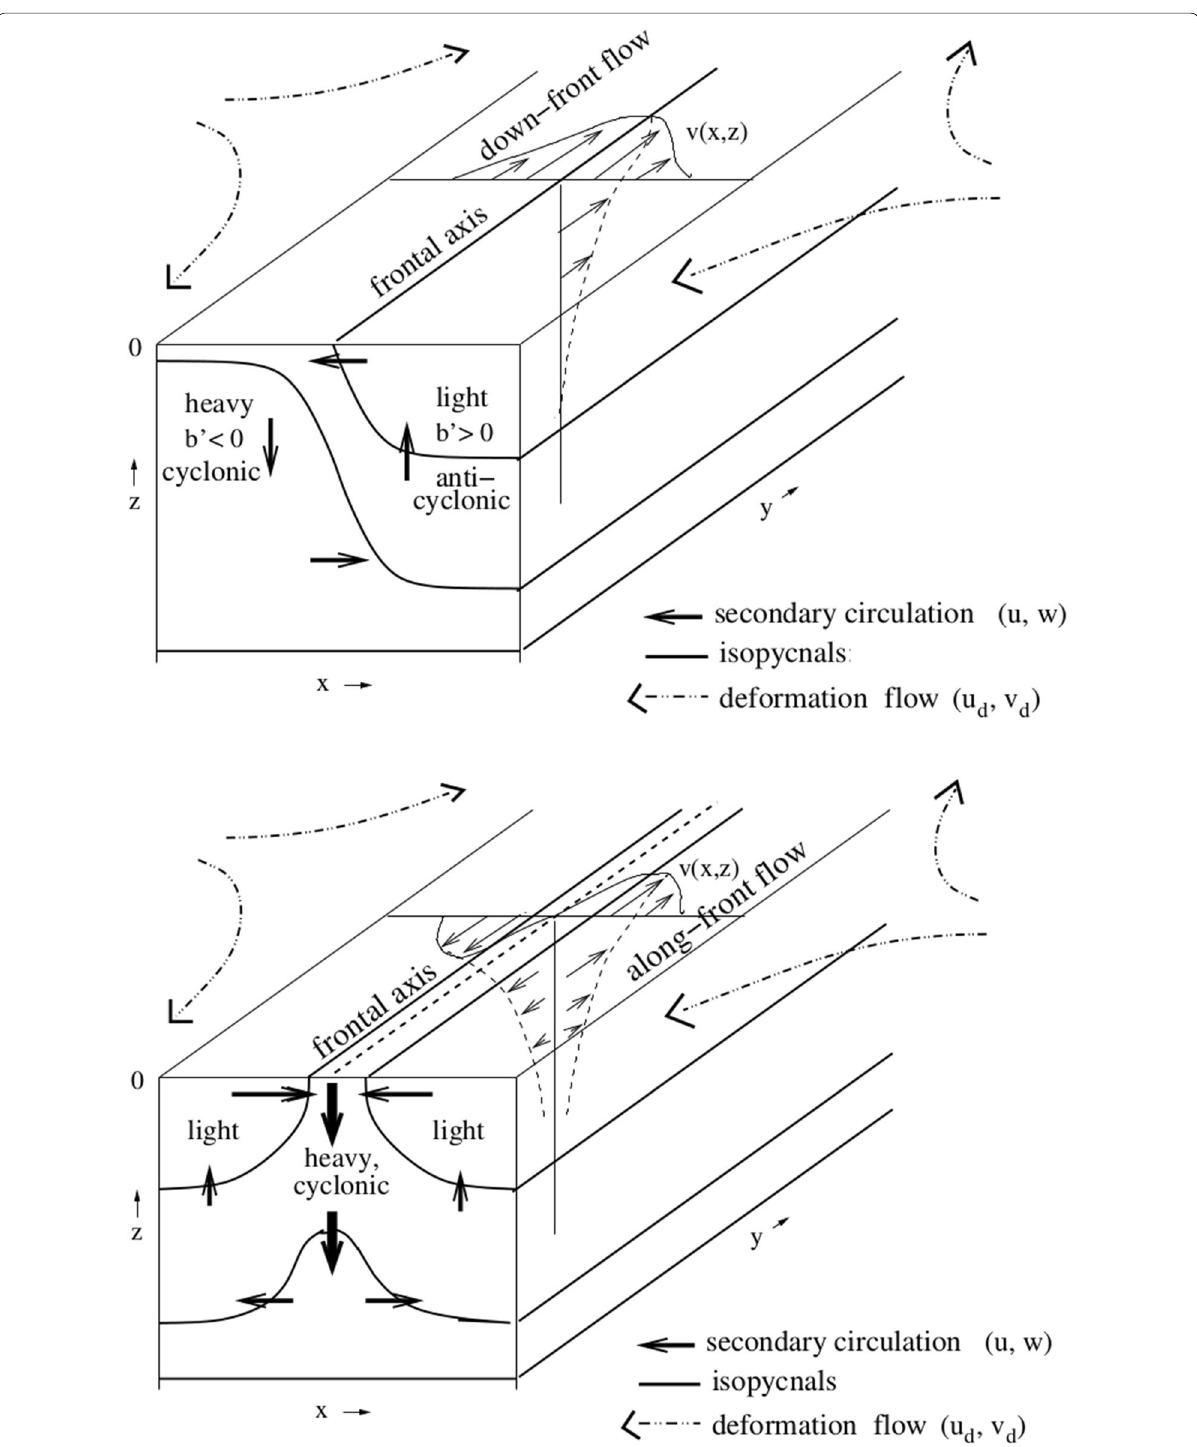
Fig. 7 Frontogenesis by strain. Sketch of surface-layer frontogenesis caused by a larger scale (mesoscale) deformation flow for a front (top) and dense filament (bottom) (McWilliams 2016). There is a geostrophic along-front flow and an ageostrophic secondary circulation in the cross-front plane. With finite Ro , as typical of SMCs, the downwelling and cyclonic vorticity zones are stronger than the upwelling and anticyclonic